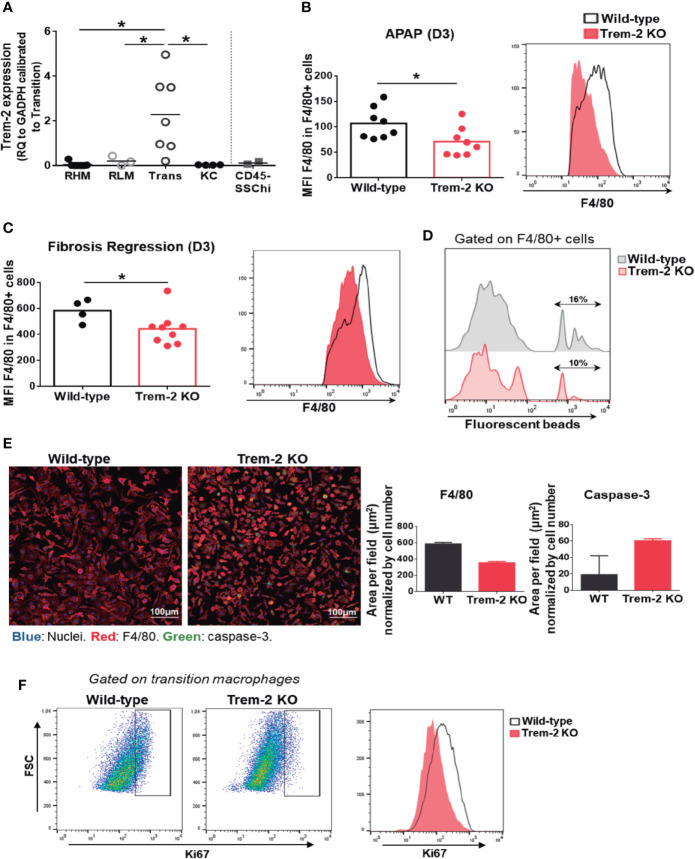
Trem-2 is implicated in acquisition of liver transition macrophages phenotype. Trem-2 gene expression was evaluated by qPCR in sort-purified macrophage populations and in non-hematopoietic cell population, CD45neg SSChi in wild-type mice and represented as fold change to transition macrophages (A). F4/80 mean fluorescence intensity (MFI) among F4/80int/high non-parenchymal cells from wild-type and Trem-2 KO mice at APAP-D3 (B) and fibrosis regression-D3 (C). Percent of F4/80int/high non-parenchymal cells containing fluorescent beads in wild-type and Trem-2 KO at APAP-D3 1 h after i.v. injection of 50x106 2μm Yellow-Green fluorescent microspheres (D). Immunofluorescence of sort-purified APAP-D3 transition macrophages from wild-type and Trem-2 KO mice after 3 days of culture (Nuclei (blue), F4/80 (red), caspase-3 (green). Merged images are shown and quantification of F4/80 and caspase-3 stained area normalized by nuclei is plotted (E). Representative flow cytometry plots showing Ki67 staining in APAP-D3 transition macrophages from wild-type and Trem-2 KO mice (F). Statistics: One-way ANOVA and Tukey’s correction in (A) Mann Whitney test in (B, C) *, p<0.05.